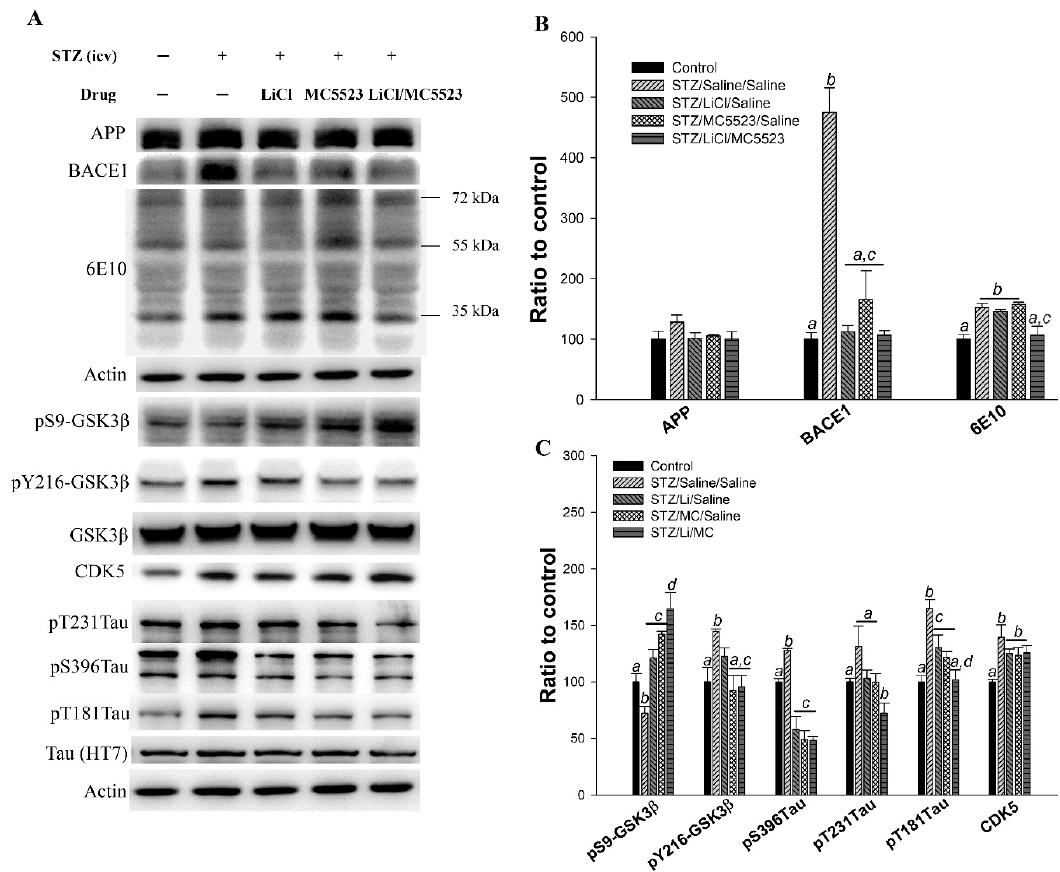
Figure 7. LiCl combined with MC5523 decreased the pathological features of AD in icv-STZ B6 mice. Representative western blots ( A ) and densitometry results ( B – C ) of APP, BACE1, 6E10, pS9-GSK3 β , pY216-GSK3 β , CDK5, and HT7 and pTau at S396, T231, and T181 with β -actin serving as an internal control. The quantitative data are shown as the mean ± SEM ( n = 3–5 per group). ** p < 0.01 and *** p < 0.001 compared with the saline/saline/saline control group. Means that do not share a letter are significantly different ( p < 0.05).